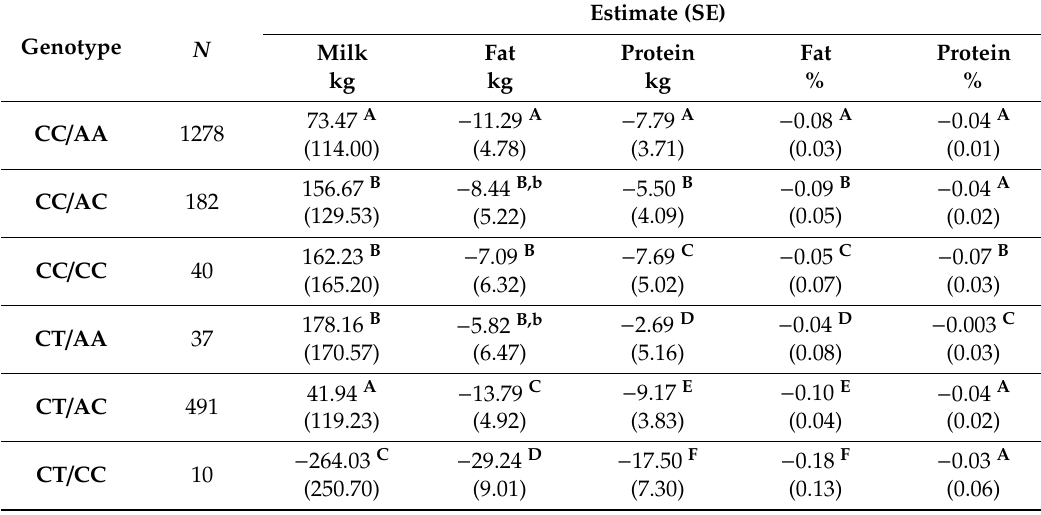
Table 3. The estimates and their standard errors (SE) of e ff ects of defensin genotypes for the breeding values of the investigated